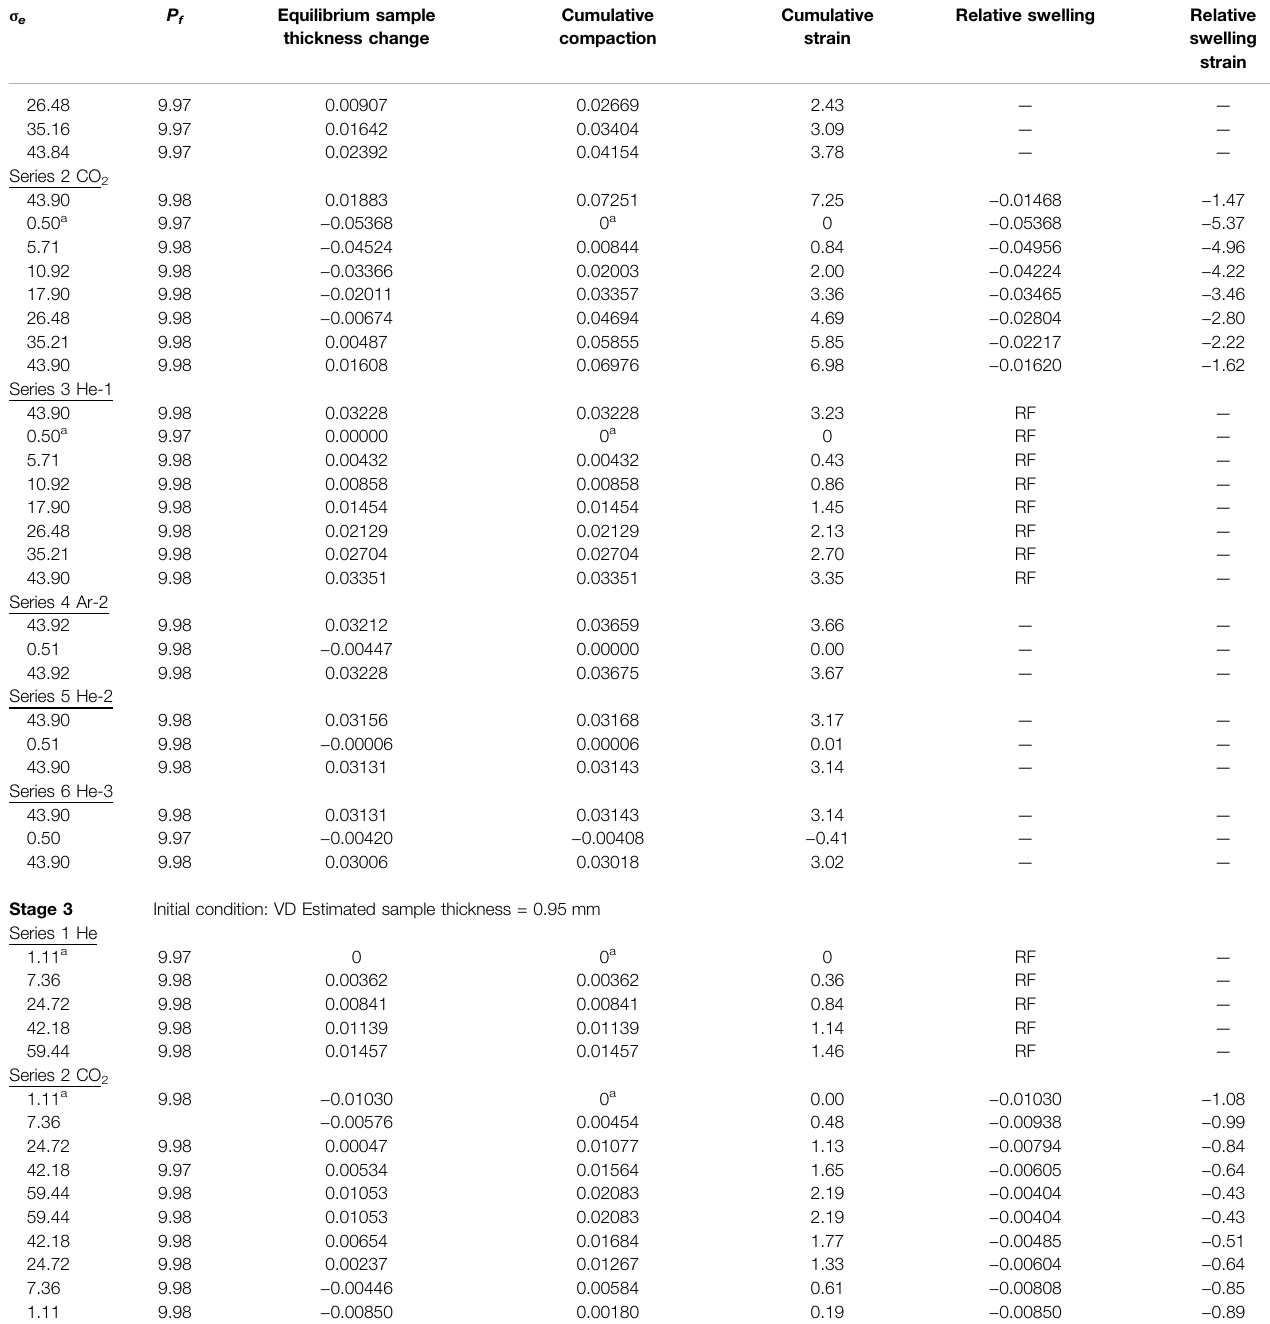
RFdenotesthedata(obtainedwithHeorAr)selectedasreferencepointsforcalculatingrelativesampledeformationwithCO 2 versuswithinertpore fl uid.EquilibriumLVDTdatahavebeen correctedforelasticmachinedeformation,hencerepresentingonlydeformationofthesample,i.e.changeinsamplethickness.N.B.Compressivestress,compressiveLVDTdisplacement sample compaction (strain) take positive sign. Relative swelling (strain) of the sample saturated with CO 2 relative to He/Ar, (i.e. increase in sample thickness with CO 2 versus He/Ar), is accordingly de fi ned as negative. Each series shown represents a load cycling sequence performed with a given fl uid. a Indicates the reference state, relative to which the cumulative sample compaction and compaction strain were calculated.